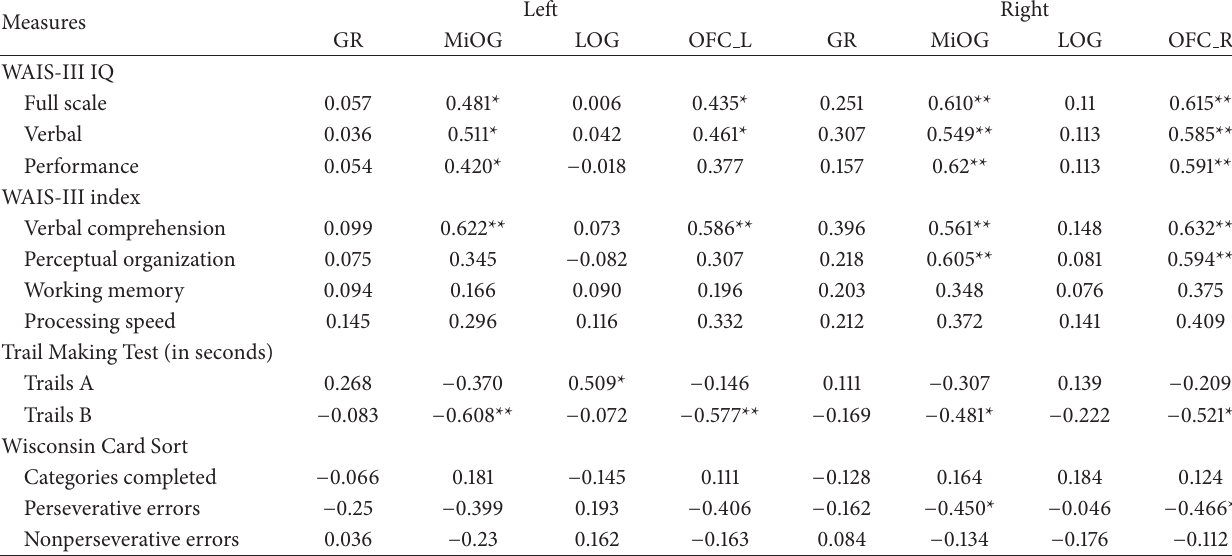
Table 4: Pearson correlations of orbital frontal cortex volumes and neuropsychological